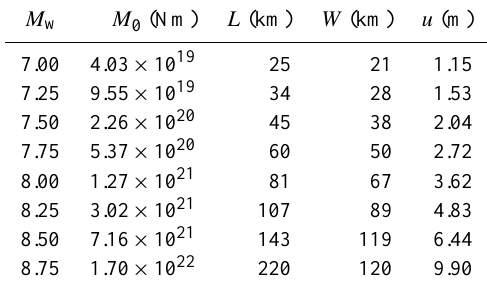
Table 2. Main parameters for the WLU-1 model of large earthquake generation in the Gulf of Cadiz-SW Iberia region. This model ap- plies to all zones except